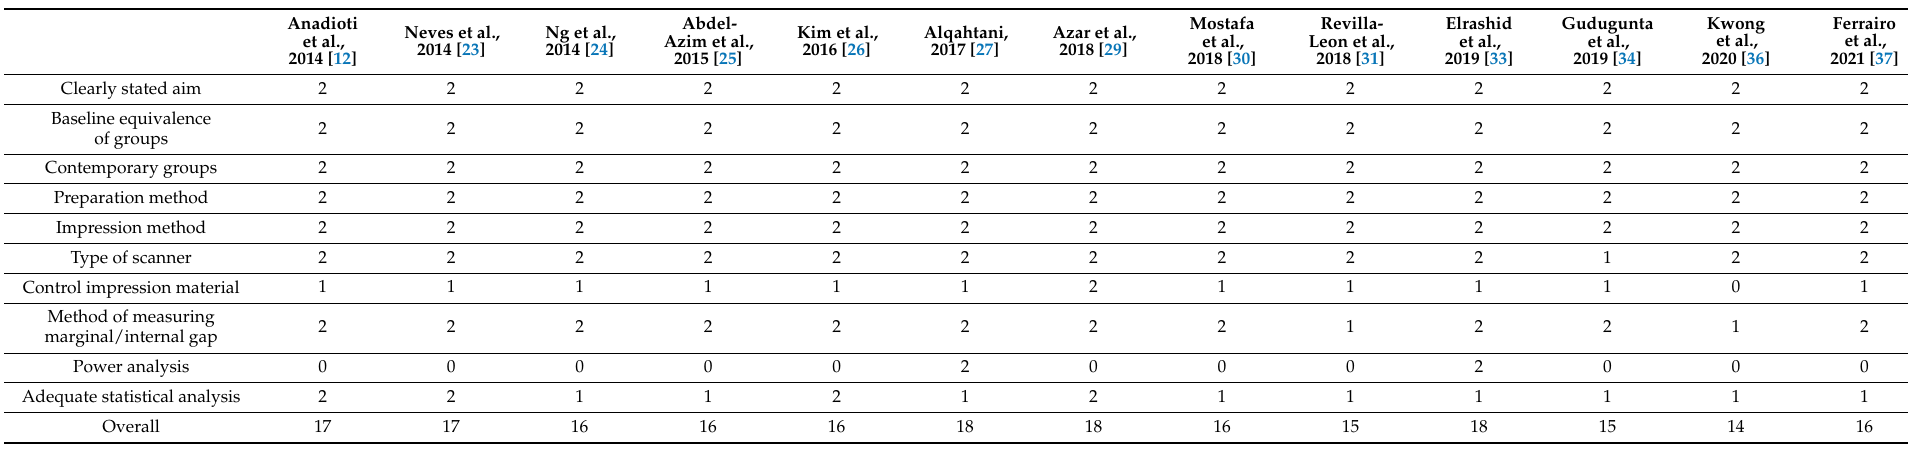
Table 7. MINORS table of included studies.